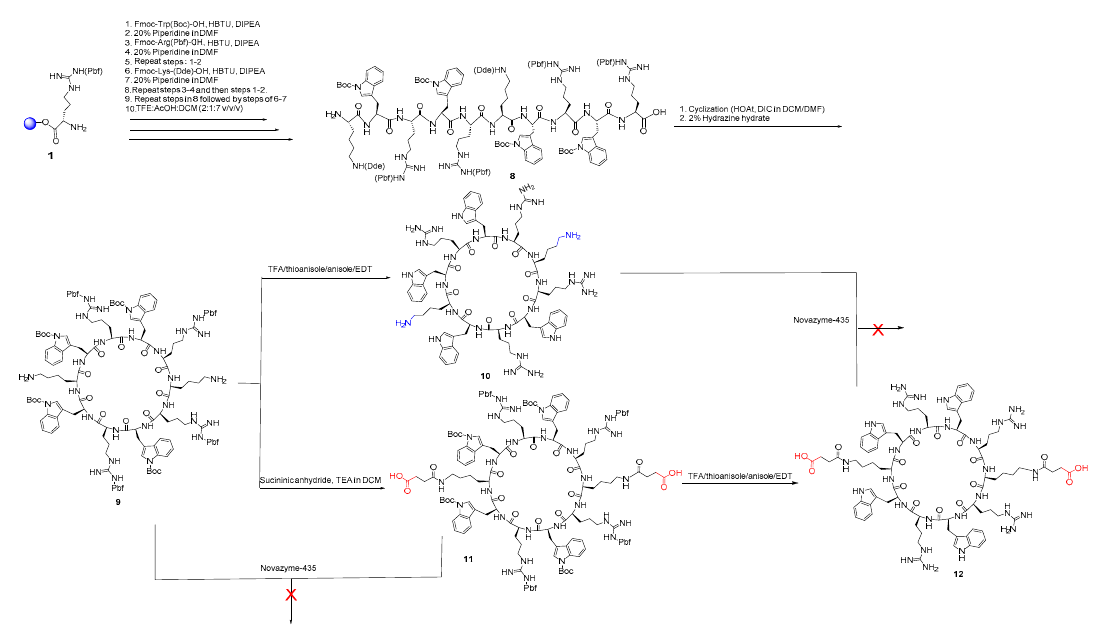
Scheme 2. Synthesis of cyclic peptides containing two free amino or two free carboxylic acids.